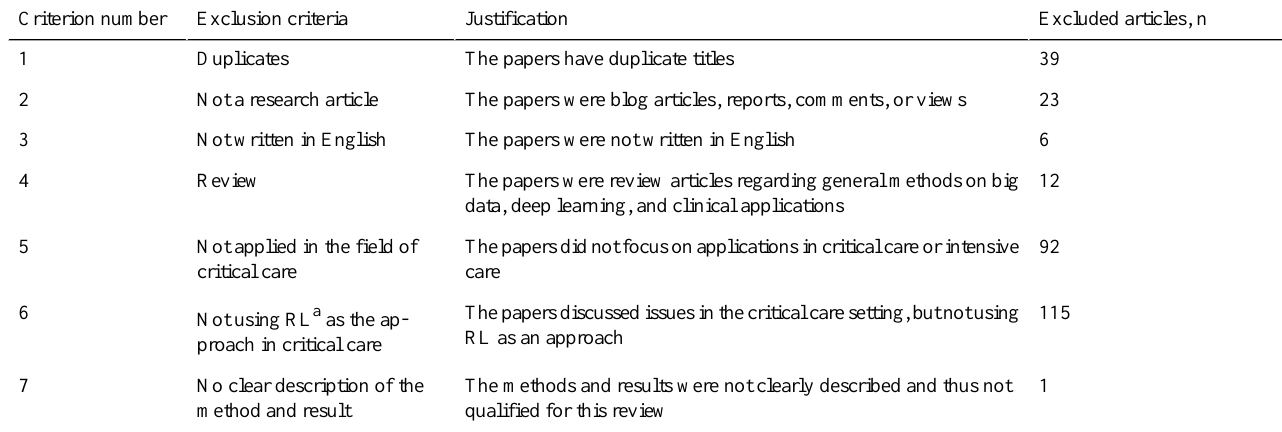
Table 1. Exclusion criteria used to exclude